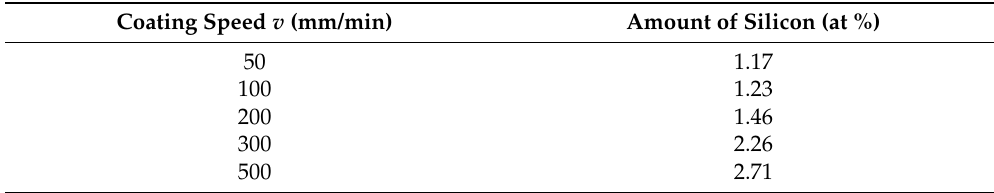
Table 1. Measured amounts of silicon on the substrates by varying the process speed in the modification step.